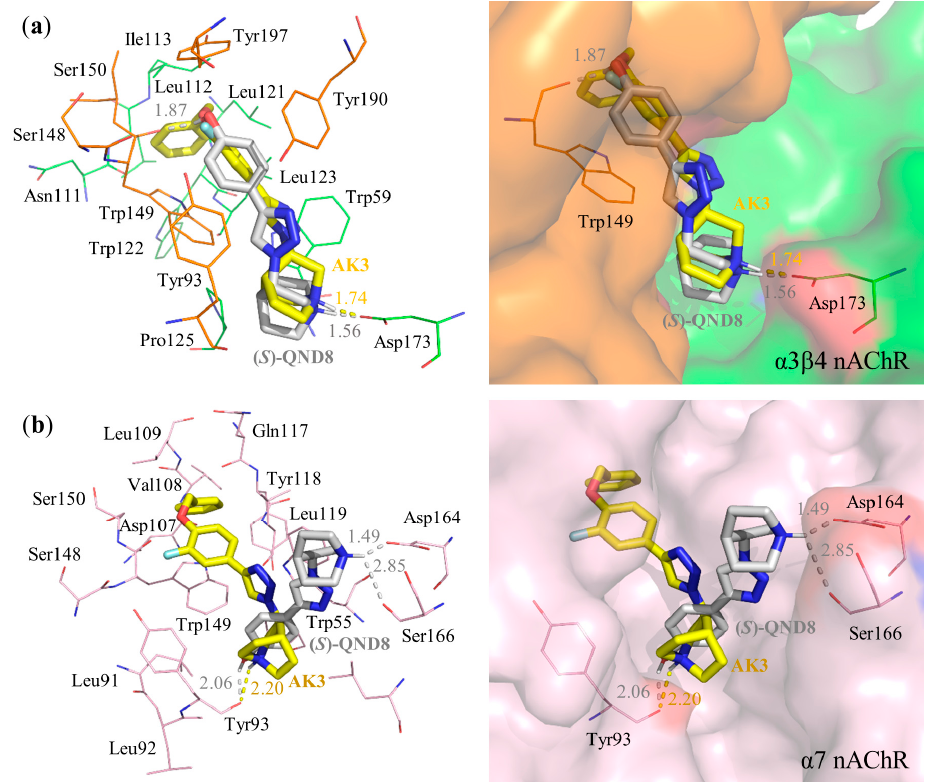
Figure 5. The overlay binding modes of AK3 and ( S ) - QND8 against ( a ) α 3 β 4 nAChR and ( b ) α 7 nAChR. Orange, green, and light pink indicated α 3 , β 4, and α 7 subunits, respectively. Table 3. The amino acid residues involved in the binding interaction to α 7 nAChRs.